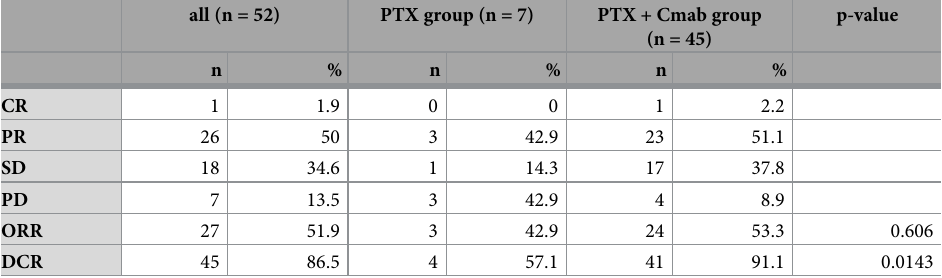
Table 2. Best of response of SCT(PTX vs PTX +